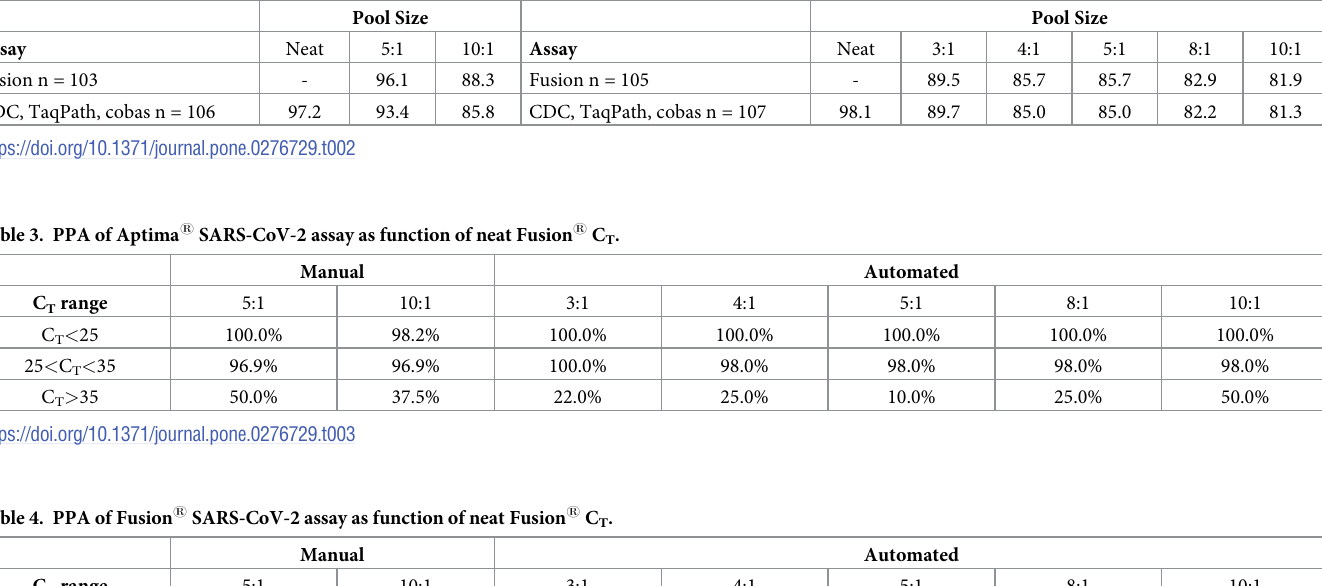
Table 2. PPA between Fusion 1 SARS-CoV-2 pooled test results and neat test results from three SARS-CoV-2 assays.